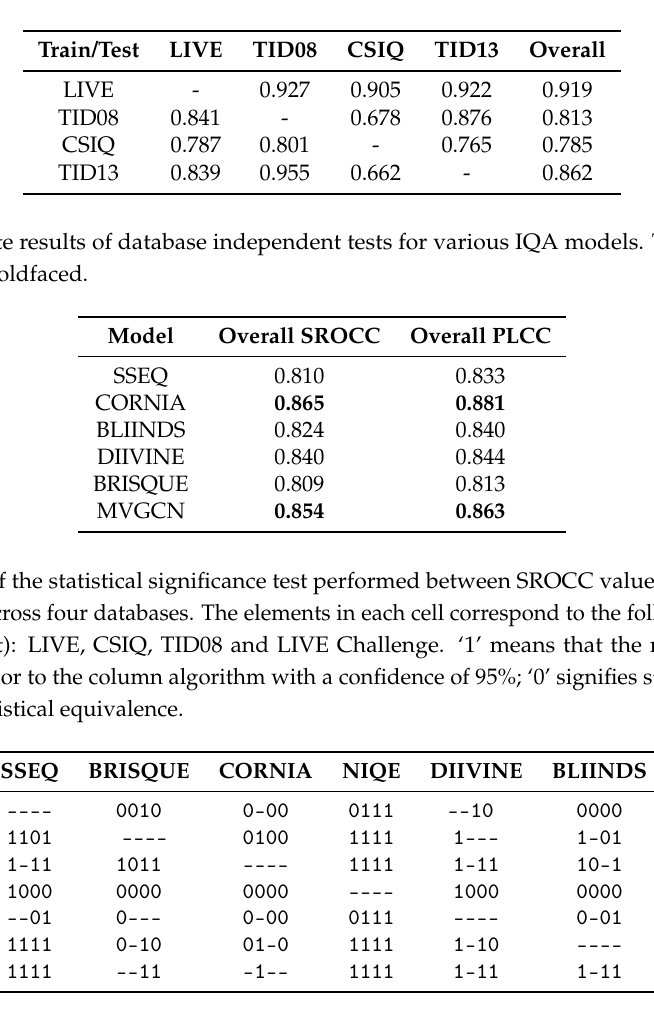
Table 3. SROCC for database independent experiments on MVGCN across multiple IQA databases. Rows: training dataset; columns: testing dataset. The overall performance is calculated for each training database.